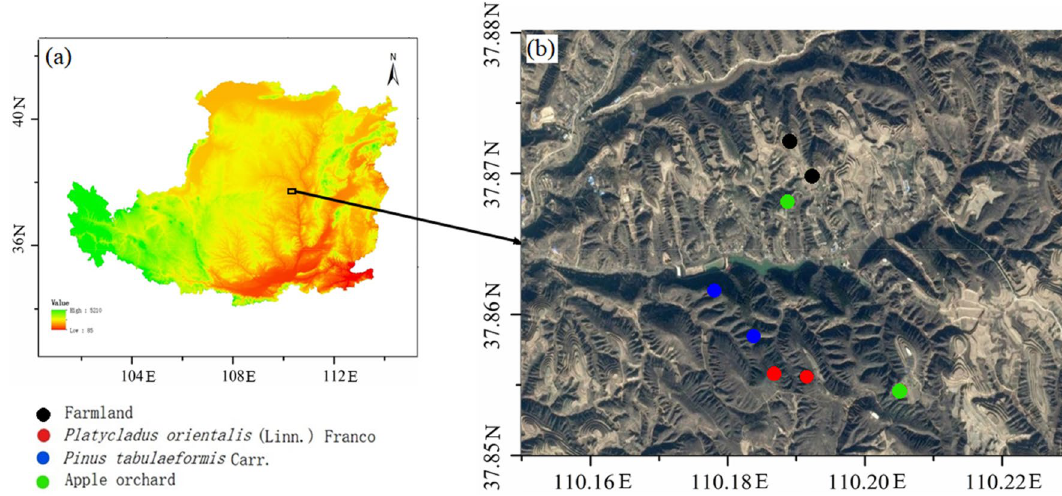
Figure 1. Distribution of the sampling sites in the study area (map created using ArcGIS 10.2 software by first author, http:// www. esri.